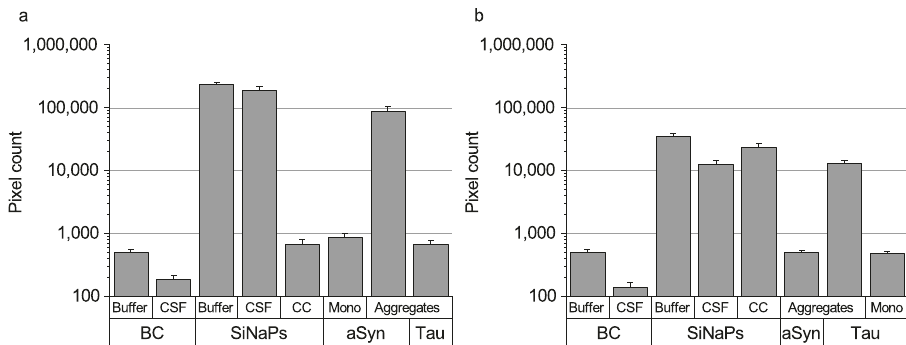
Fig. 5 Pixel counts of assay controls for the detection of aSyn and Tau aggregates. a aSyn SiNaPs showed a recovery of 79% in CSF, whereas b Tau SiNaPs showed a recovery of 36% in CSF. Synthetic aSyn and Tau aggregates served as positive controls. The pixel counts of the aSyn aggregates when detected with the Tau5 antibody as well as the pixel counts of the Tau aggregates when detected with the 211 antibody were as low as the blank control (BC). The pixel count of 8 nM monomeric (Mono) aSyn as well as 200 nM monomeric Tau was reduced by 99.5% compared to the same concentration of monomer units in aggregated aSyn or Tau. When the capture antibody was omitted (capture control, CC), no signal was detected for aSyn SiNaPs, whereas the signal for Tau SiNaPs was still at 67%. Standard deviation was calculated from the four replicates.